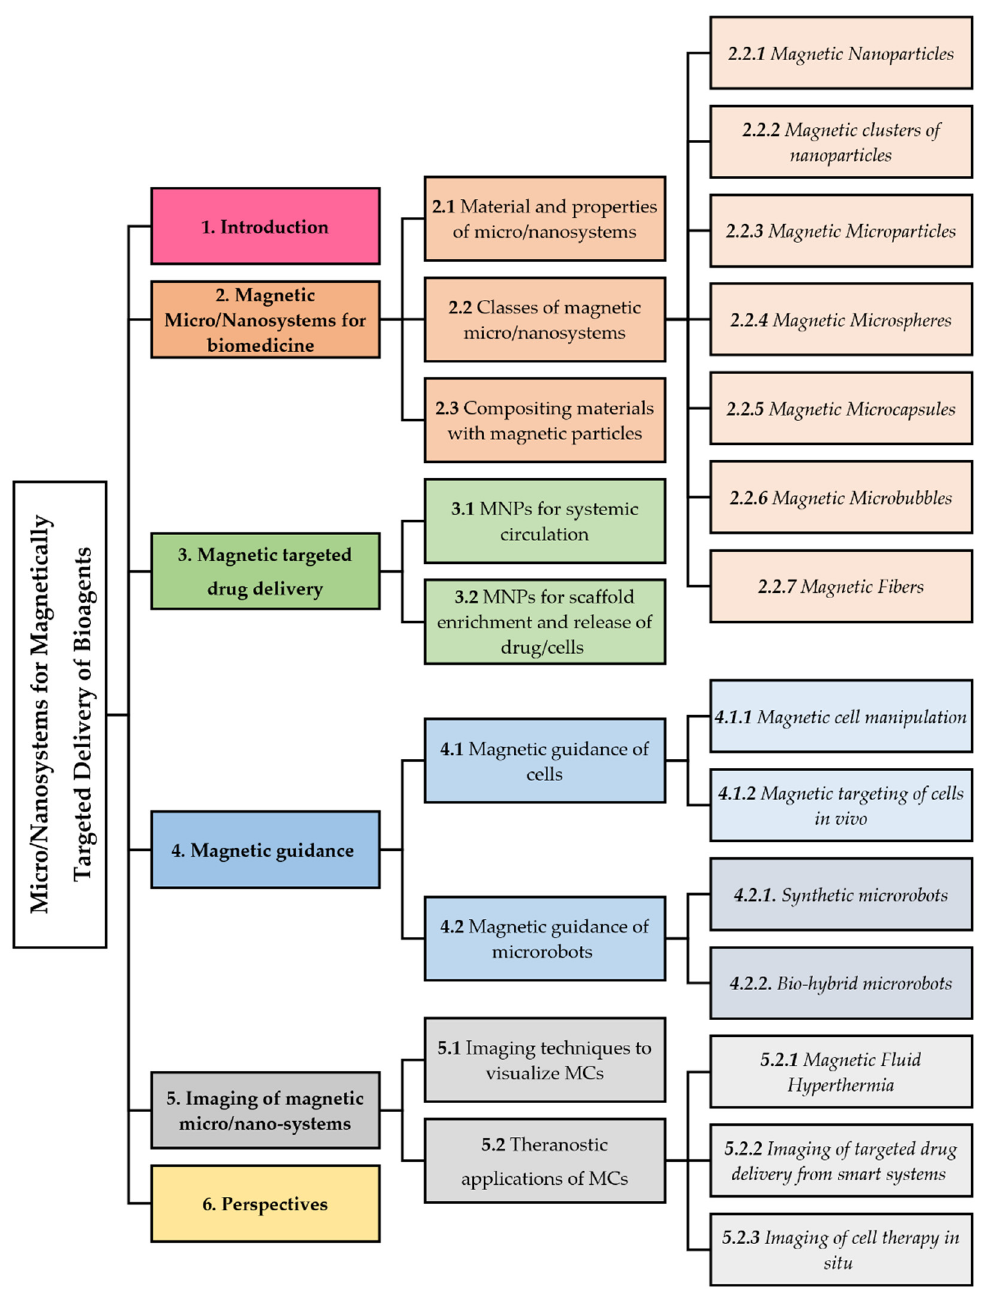
Figure 1. Schematic diagram of the review